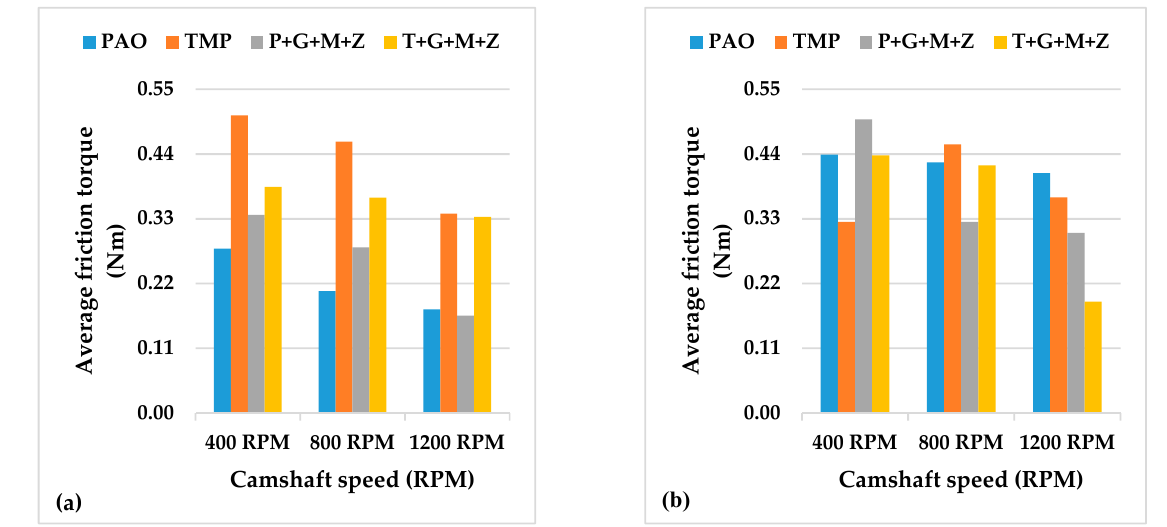
Figure 5. Average friction torque of exhaust camshaft with a-C:H-coated tappets and a-C:H-coated camlobes at camshaft speeds of 400 RPM, 800 RPM, and 1200 RPM and lubricant temperatures of ( a ) 40 °C and ( b ) 90 °C.